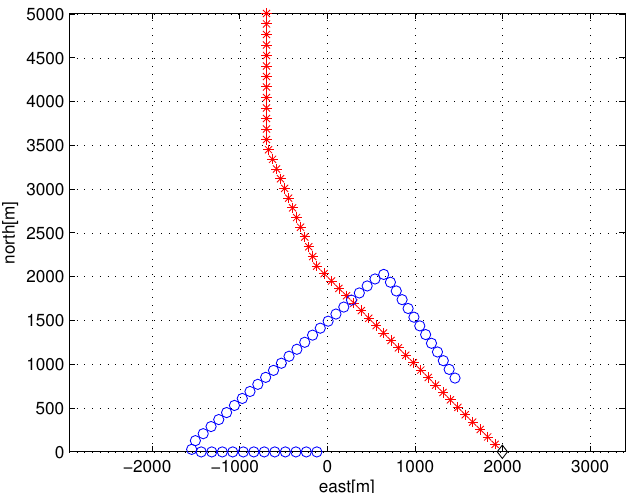
Figure 1. The AUV starts from the origin. The ship starts from (2000,0) in meters, and the trajectory of the ship at every minute is plotted with red asterisks. The starting point of the ship is marked with a diamond. At every minute, the trajectory of the AUV is depicted with blue circles (one ship